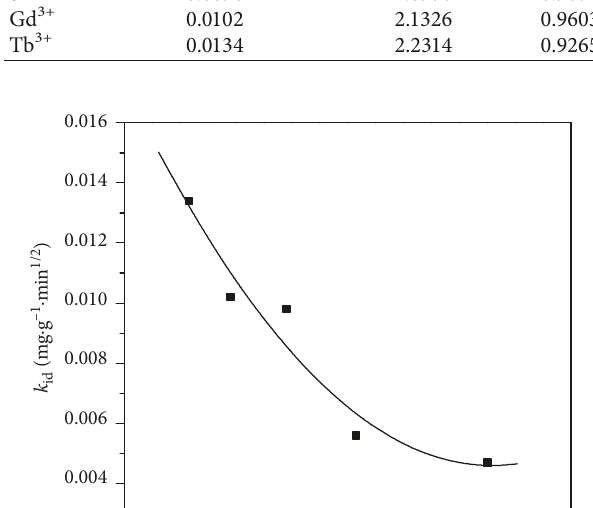
id values; (b) plot